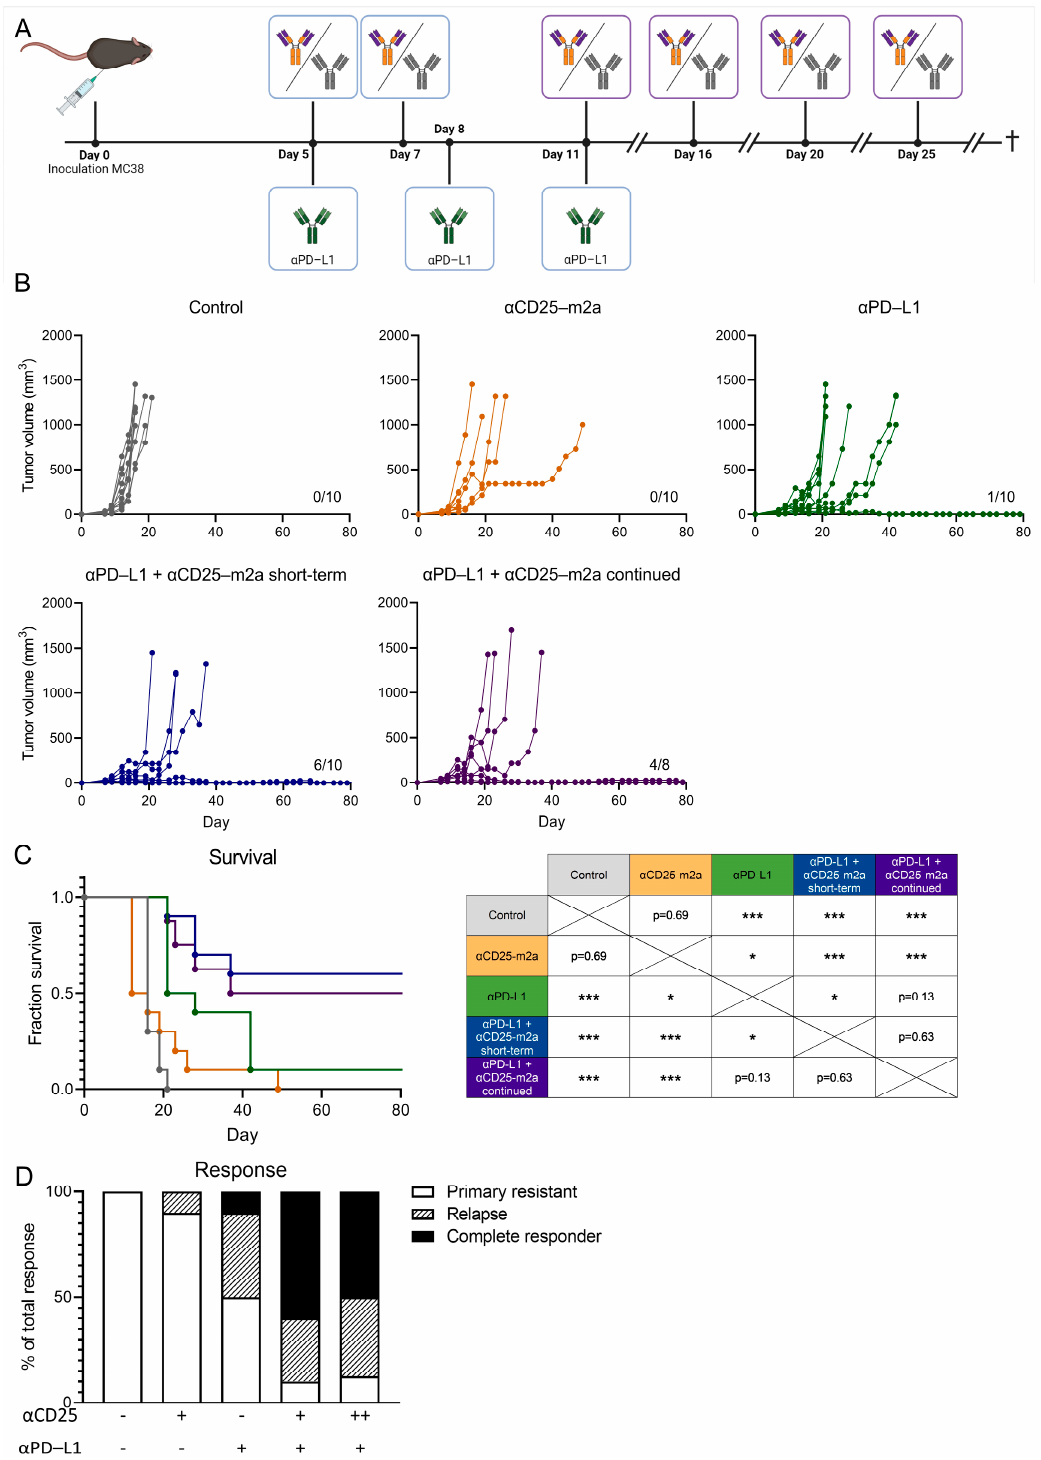
Figure 4. Continued T reg depletion does not affect therapeutic efficacy. ( A ) Schematic of treatment schedule of C57/BL6 mice inoculated with MC38. On day 0, mice were subcutaneously inoculated with MC38 and subsequently treated on days 5 and 7 with α CD25-m2a (short-term) or days 5, 7, 11, 16, 20, and 25 (continued) or an isotype control, or treated on days 5, 8, and 11 with α PD-L1, or received both α CD25-m2a and the α PD-L1 treatment. Mice were euthanized when tumors reached a volume of 1500 mm 3 . ( B ) Growth curves of MC38 tumors. Number of tumor-free survivors is shown in each graph. ( C ) Survival curves including significance table and ( D ) response rates of mice shown in ( B ) ( n = 8–10, statistical difference determined via log-rank test). Significance is shown as * = p < 0.05, and *** = p < 0.001.